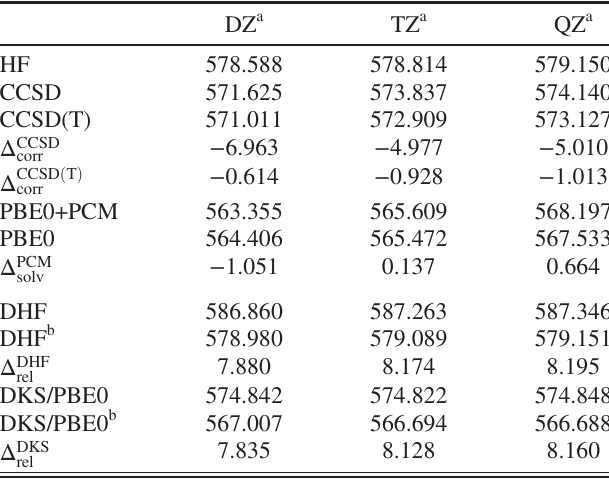
a DZ, TZ, and QZ represent double- ζ , triple- ζ , and quadruple-